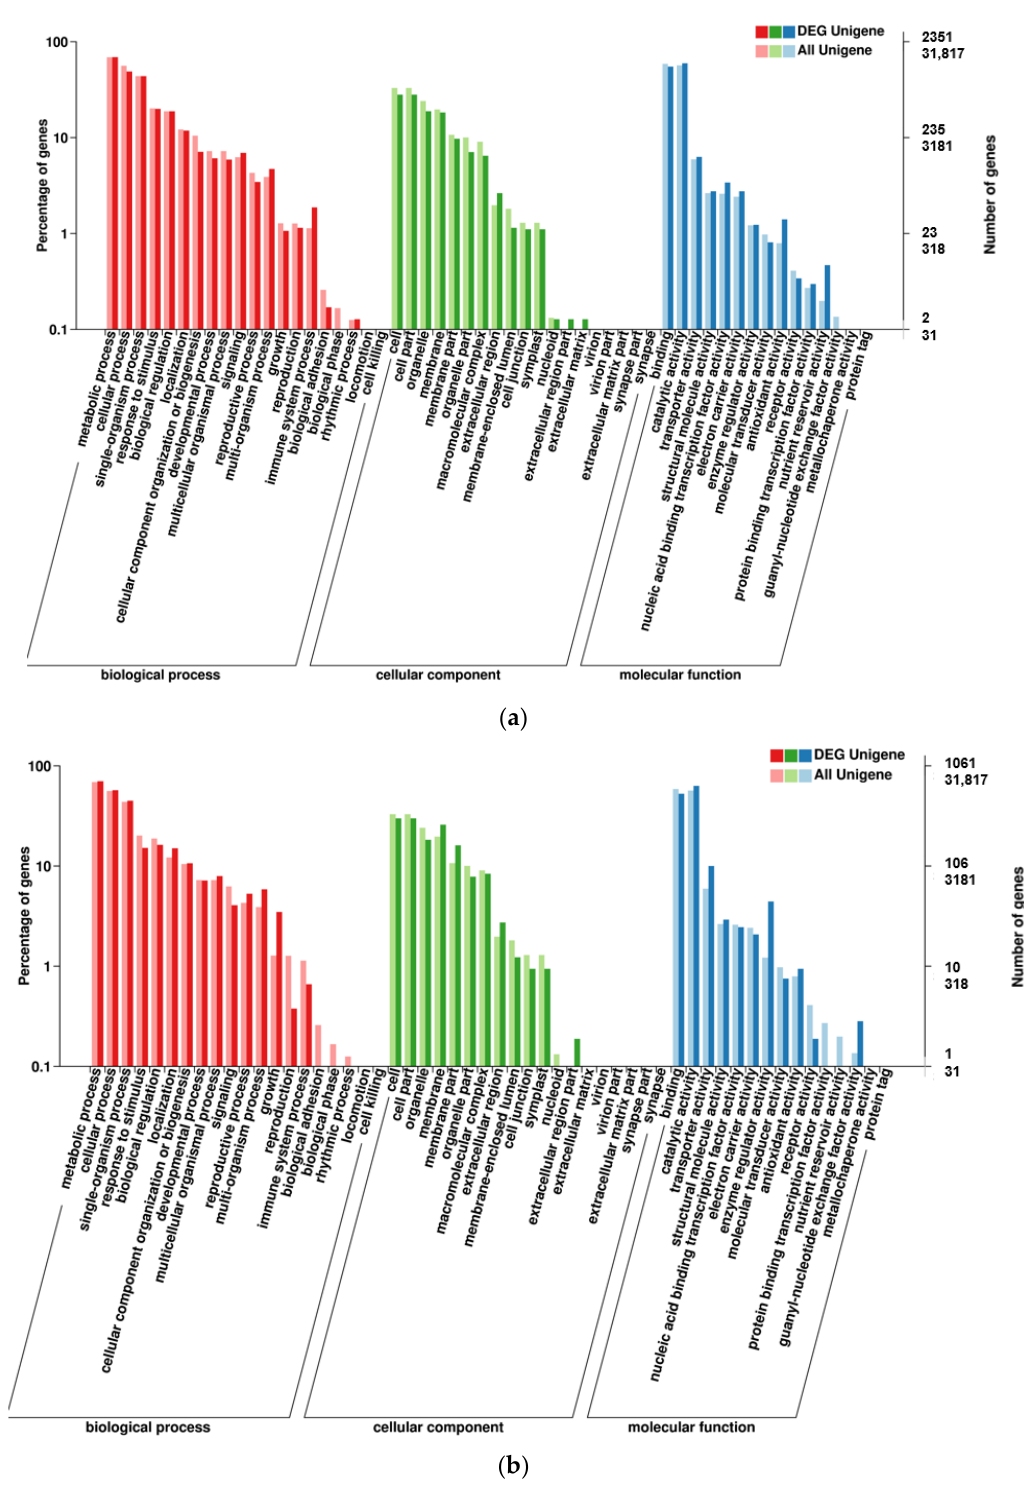
Figure 4. GO enrichment of DEGs in two compared groups. ( a ). T01-vs.-T02 compared group. ( b ). T04-vs.-T03 compared group.